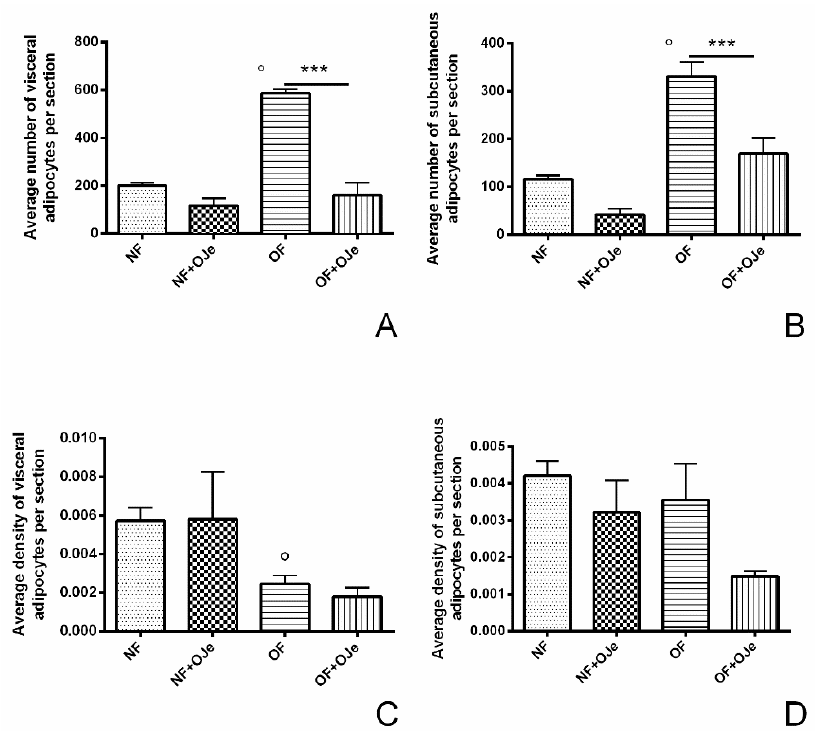
Figure 4. OJe reduced adipocyte number and density in OF zebrafish. Morphometric analysis of visceral ( A ) and subcutaneous ( B ) fat displays a reduction in the number ( A , B ) of adipocytes in OF + OJe fish compared with OF untreated ones, while their density was statistically reduced only at the subcutaneous level ( D ) but not at visceral one ( C ). Values reported in the graphs are expressed in µm 2 of adipose tissue per section and represent the mean ± SD of 10 animals per each group. *** p < 0.001 vs. respective counterparts; ° p < 0.001 vs NF.